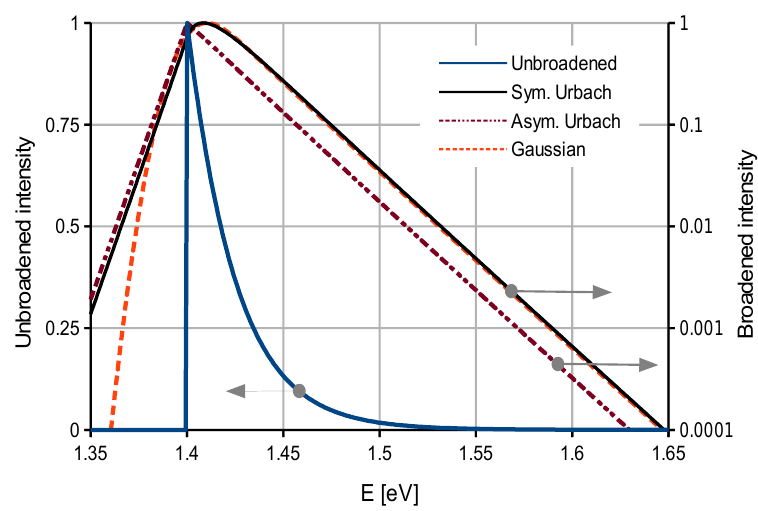
Figure 2. Inhomogeneos lineshapes for the unbroadened qw-spectrum, (cid:101)ρ Jdos ( (cid:101) ) S ( (cid:101) ) exp ( − (cid:101) / k B T ) , obtained by convolving with three L Jdos lineshapes. In the Urbach functions E u = 8 meV and in the Gaussian σ = 10 meV. [T = 293 K, E b = 8